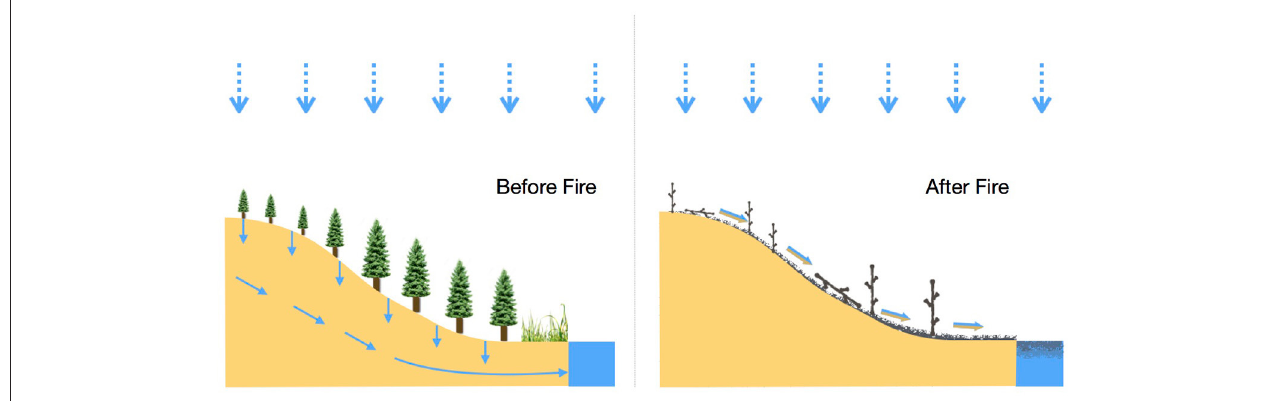
FIGURE 1 | On the hillslope scale, fires alter dominant hydrologic flow regimes in soil, reducing infiltration and subsurface flow of water, and increasing surface